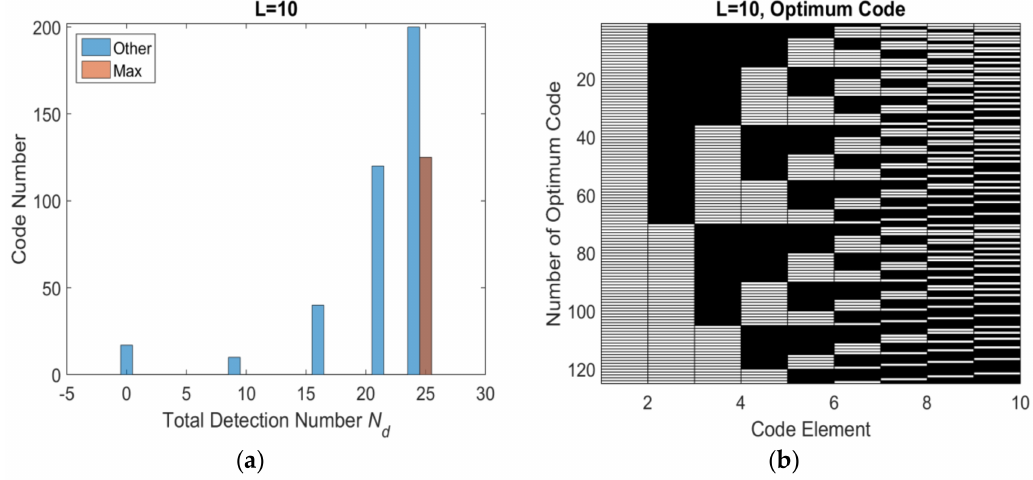
Figure 8. L = 10 optimum codes and corresponding N d ( a ) histogram distribution of N d ( b ) optimum